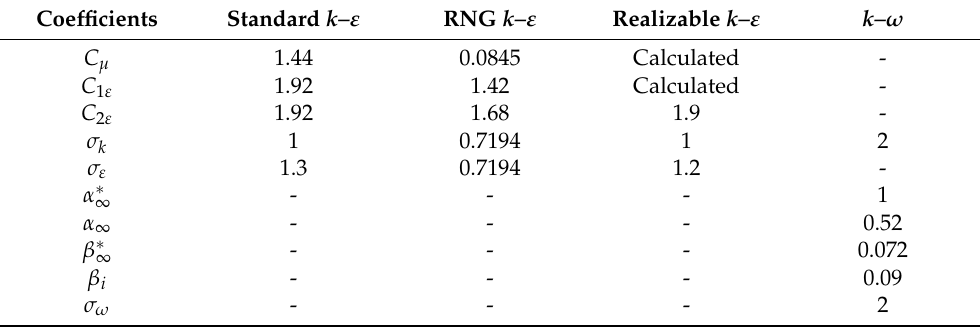
Table 2. Coefficients for the adopted turbulence